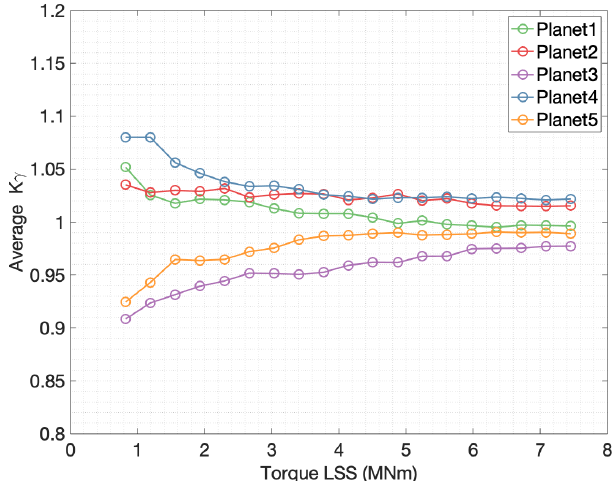
Figure 9. Average K γ per planet for each sensor.